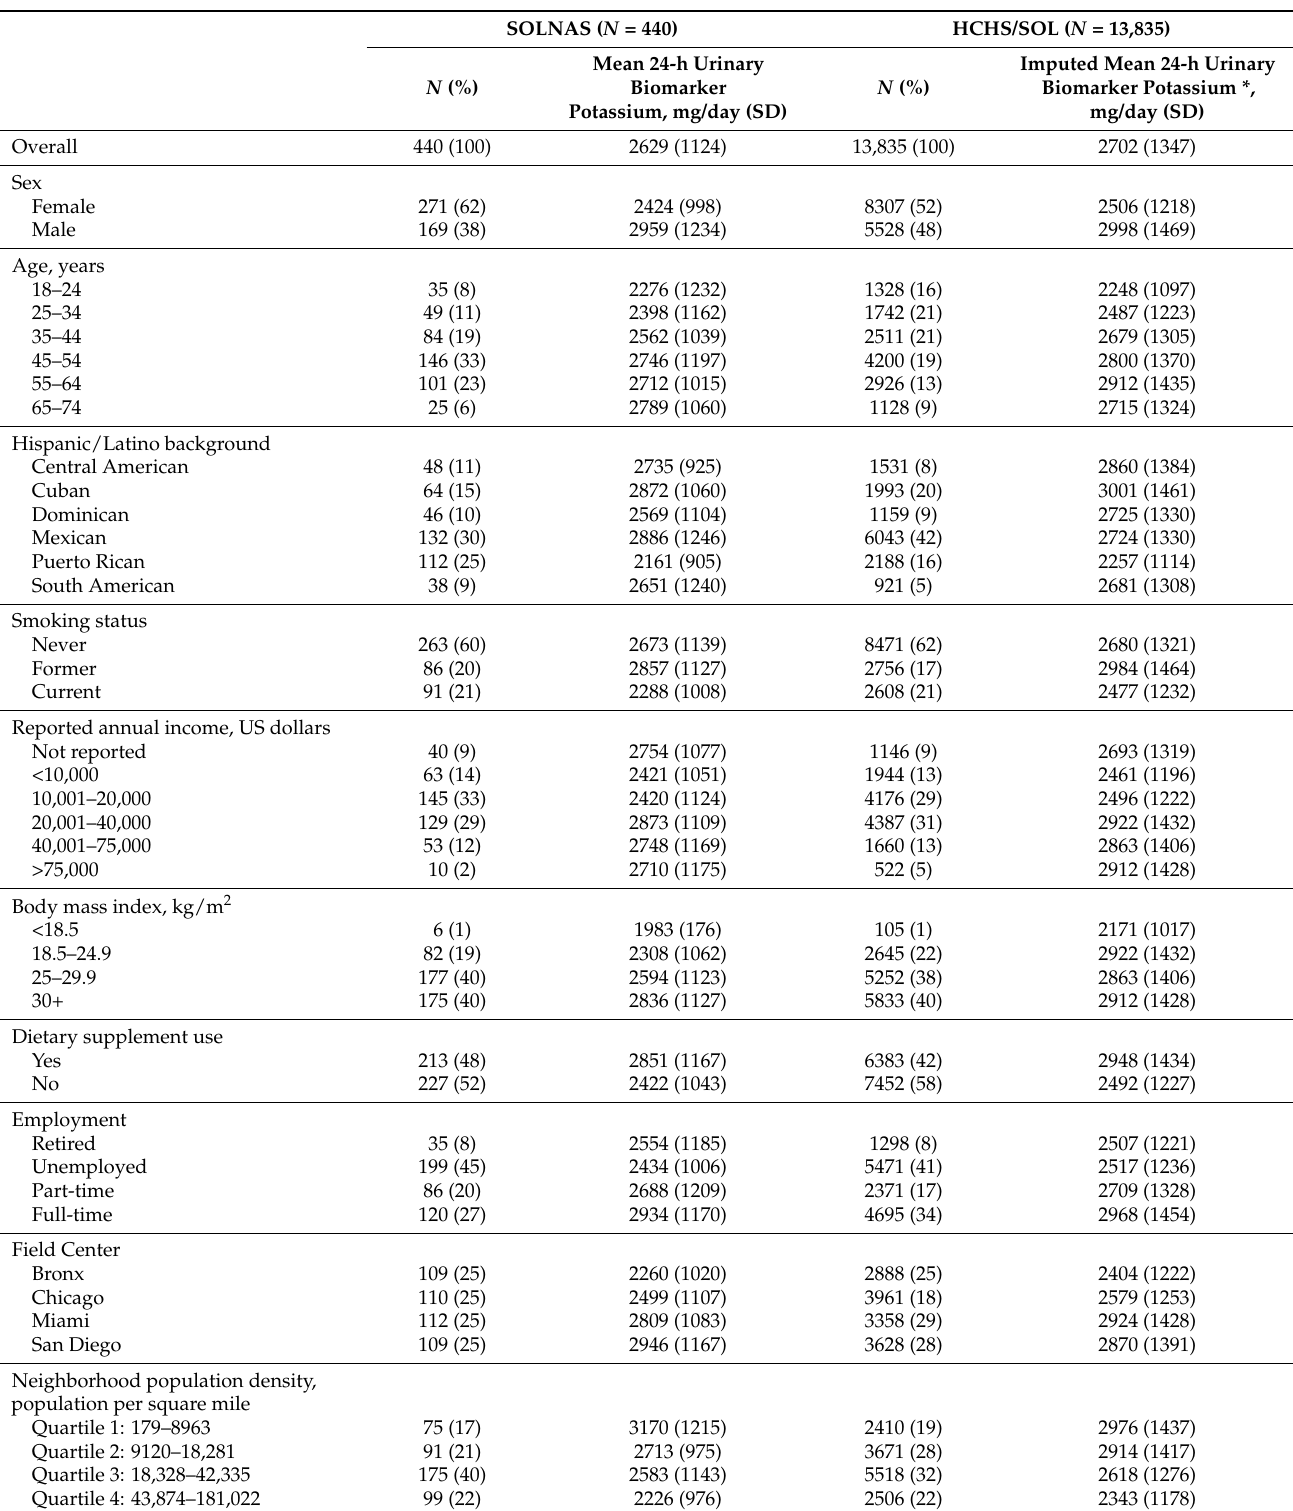
Table 1. Individual-level and neighborhood-level characteristics of SOLNAS and HCHS/SOL participants and 24-h potassium